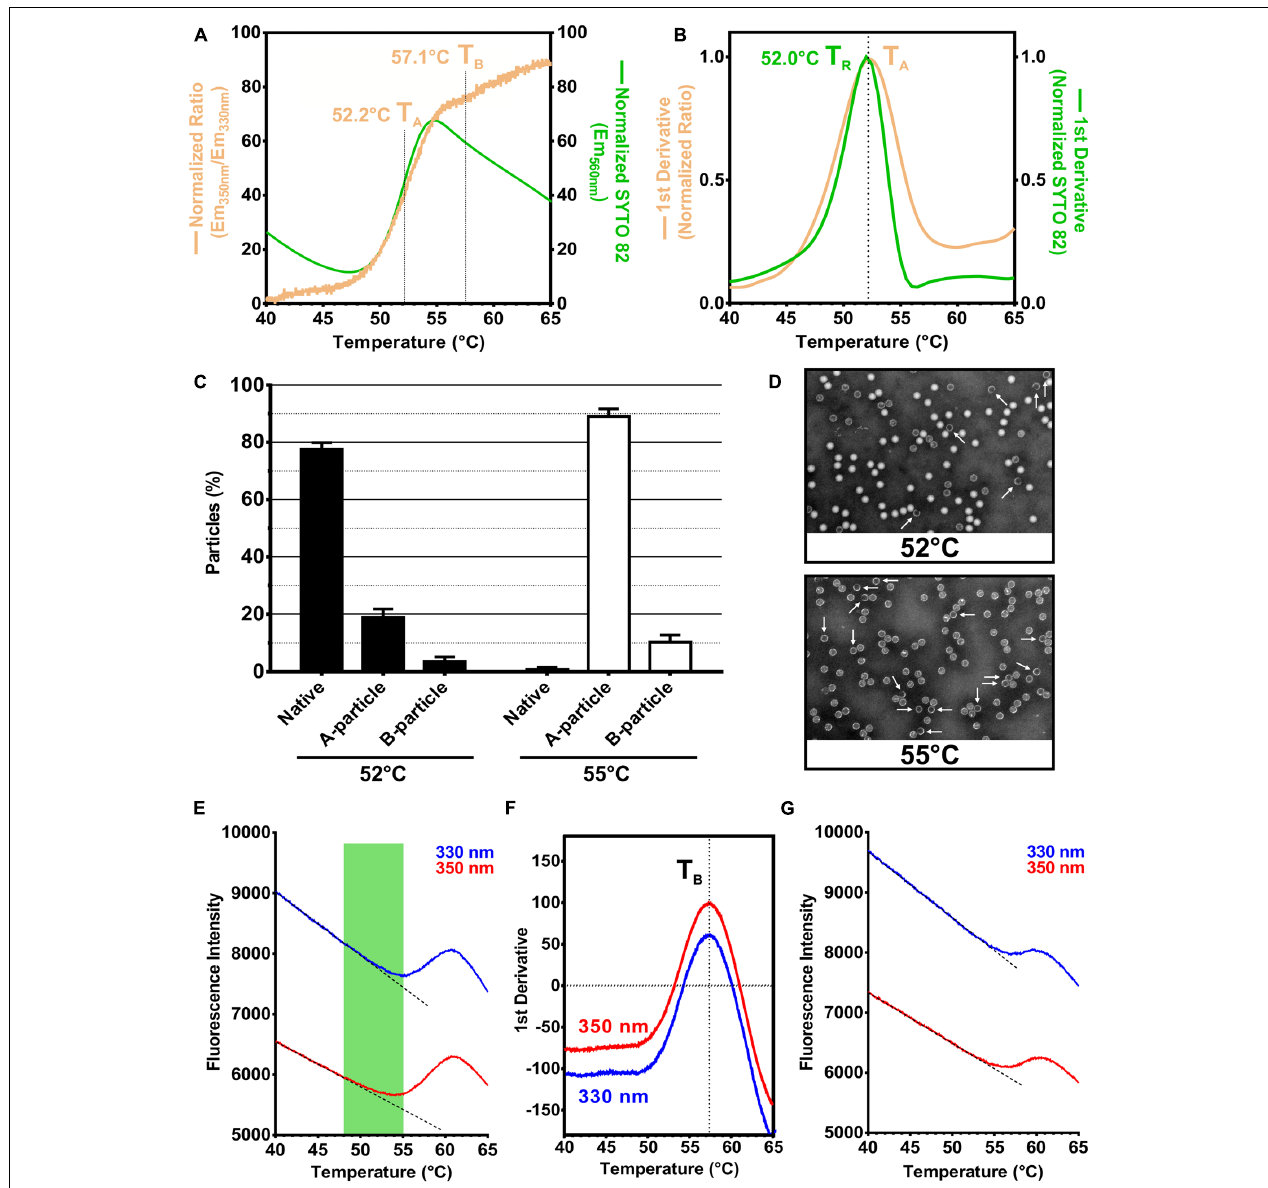
FIGURE 2 | RV-A2 nanoDSF and PaSTRy analysis and correlation with negative stain ultrastructure analysis. (A) RV-A2 in PBS (1 mg/ml) was analyzed by nanoDSF by heating from 25 to 95 ◦ C with a ramp rate of 1 ◦ C/min. Samples were excited at 280 nm, and the intensity of the TRP emission at 330 and 350 nm was recorded for every ∼ 0.02 ◦ C temperature increase. In the PaSTRy assay, the virus preparation (0.5 mg/ml) was heated in a real-time PCR machine from 25 to 95 ◦ C at a 1.5 ◦ C/min ramp rate. Samples were excited at 541 nm, and the emission intensity was determined at 560 nm at each 0.5 ◦ C temperature increase. The obtained data were plotted against the temperature, with the left Y -axis indicating the TRP fluorescence emission ratio as the intensity at 350 nm/intensity at 330 nm (curve is shown in orange) and the right Y -axis the normalized SYTO-82 emission intensity at 560 nm (curve is shown in green). (B) First derivatives calculated from the experimental data shown in panel (A) . All curves (in panels A,B ) were normalized to their individual minimum and maximum values using GraphPad Prism 6.01 for better comparison and represent the mean of 3 independent thermal scans; only the temperature range relevant for the heat-triggered virus uncoating is shown. T A is the temperature where 50% of N into A particle conversion takes place, T B corresponds to 50% conversion of (full) A into empty B particles. (C) RV-A2 in PBS was subject to the same thermal gradient as in the nanoDSF analysis, using a real-time PCR machine instead. The heating was terminated at 52 and 55 ◦ C, and the samples were quickly placed on ice followed by particle imaging via negative stain transmission electron microscopy. A, B and remaining N particles were counted and identified based on their differential dye penetrability. The percentage of (sub)viral particles in each class is presented as a bar graph for each temperature, normalized to the total number of native particles before heating. In total, ten distinct fields were evaluated, and the mean and standard deviation calculated. (D) Representative micrographs at a magnification of 110 kx (B particles are indicated with white arrows). (E) Graphs of the 350 and 330 nm TRP emission of heated RV-A2 as used for the ITF ratio calculation in panel (A) . Dotted straight lines represent the pretransition baseline obtained by data fitting in each instance. The temperature window encompassing the TRP red-shift as a consequence of the N into A particle conversion is highlighted in green. For both curves (blue, red)